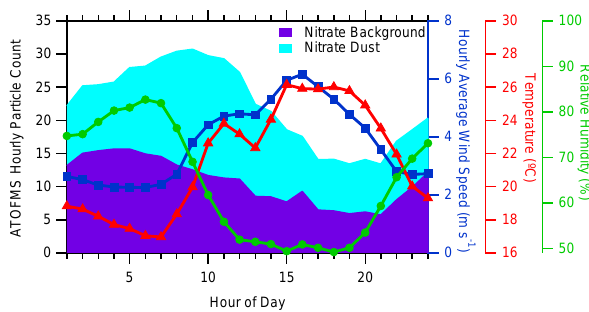
Fig. 11. Stacked diurnal trends for the Nitrate Background and Ni- trate Dust factors along with wind speed, relative humidity and tem-